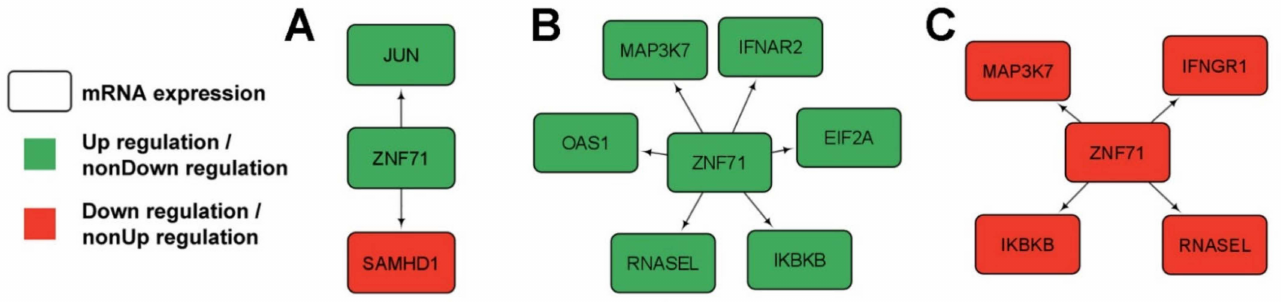
Figure 5. Direct gene co-expression networks of ZNF71 and intracellular innate immune response (IIIR) genes in lung adenocarcinoma (LUAD) patient samples using RNA sequencing data. ( A ) Direct gene associations of ZNF71 and IIIR genes when ZNF71 is upregulated in LUAD tumors. ( B ) Direct gene associations of ZNF71 and IIIR genes when ZNF71 is upregulated in NATs. ( C ) Direct gene associations of ZNF71 and IIIR genes when ZNF71 is downregulated in